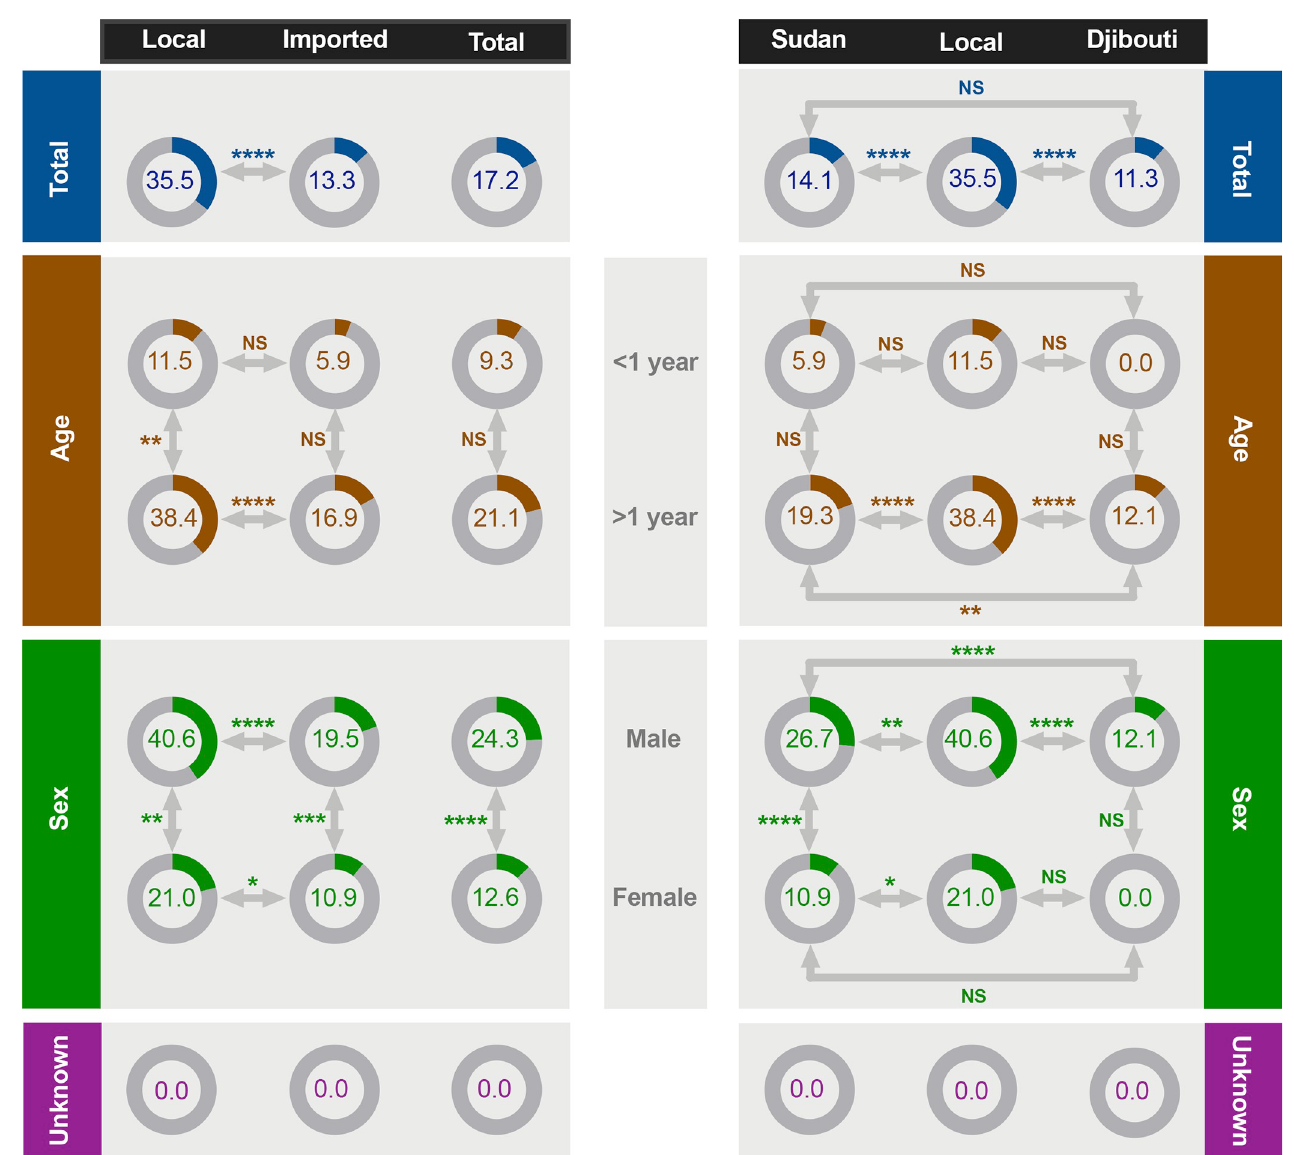
Fig 3. RNA detection rate in imported and local dromedary camels based on age and sex. Percentage of seroprevalence is shown for each category. ���� p < 0.0001, ��� p < 0.001, �� p < 0.01, � p < 0.05 and NS denotes not statistically significant (Fisher Exact Test).